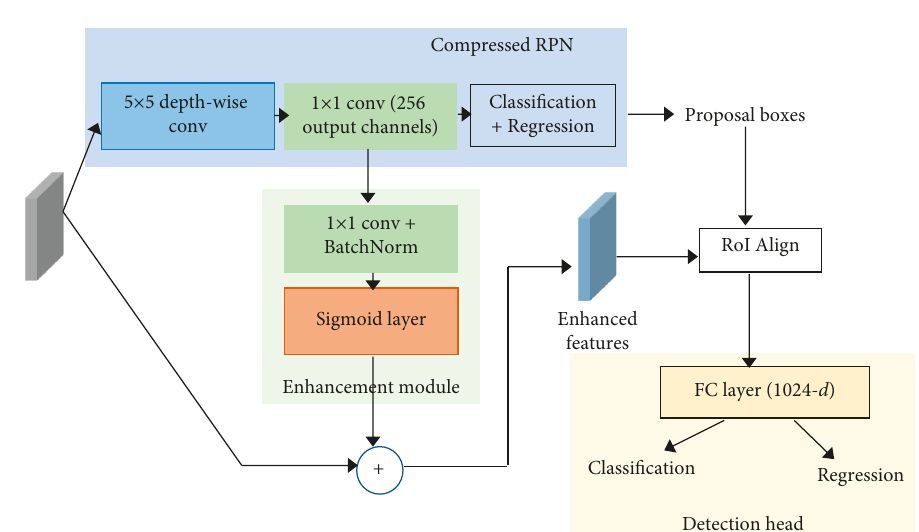
Figure 3: The lightweight detection head with the compressed RPN and the feature enhancement